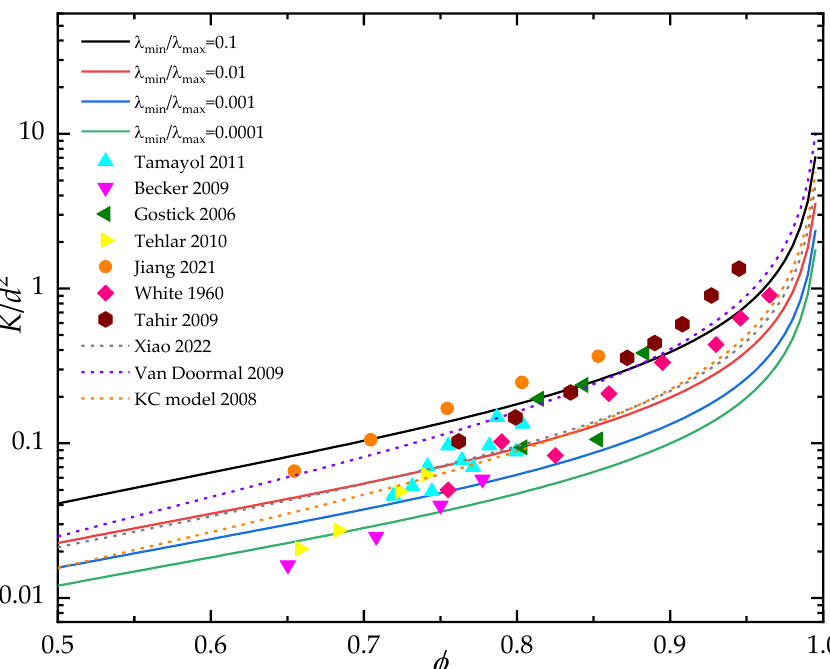
Figure 5. Comparison of predicted through-plane permeability with available experiment data and empirical formulas [56 – 65]. empirical formulas